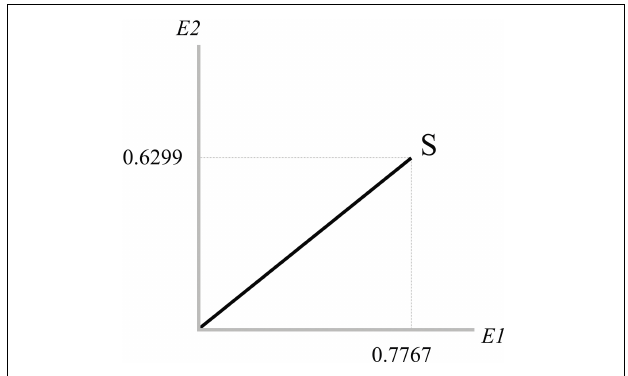
FIGURE 2 | State of the bottom-up system with evidence